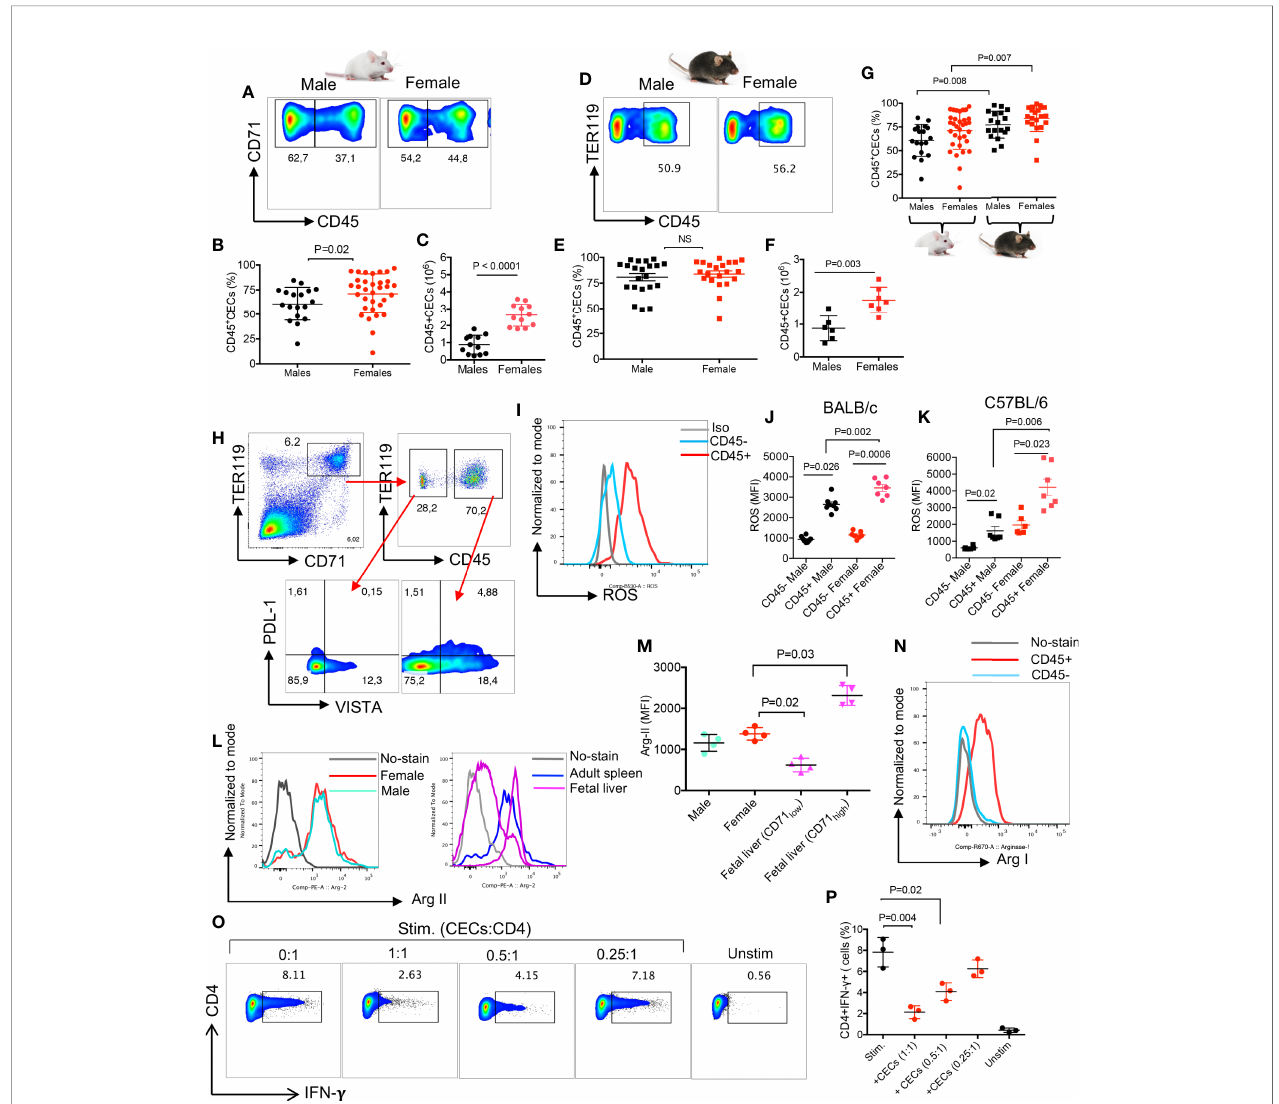
FIGURE 2 | CECs in adult mice express Arg II and ROS and suppress IFN- g production by T cell. (A) Representative fl ow cytometry plots, (B) cumulative data of percentages, and (C) absolute numbers of CD45+/CD45-CECs in the spleen of BALB/c male and female mice. (D) Representative fl ow cytometry plots, (E) cumulative data of percentages, and (F) absolute numbers of CD45+/CD45 − CECs in the spleen of C57BL/6 male and female mice. (G) Cumulative data comparing percentages of CD45+CECs in spleens of BALB/c and C57BL/6 male and female mice. (H) Representative fl ow cytometry plot of PDL-1 and VISTA expression in CD45 − and CD45+ CECs from a female BALB/c mouse. (I) Histogram plots, and (J) cumulative data of the mean fl uorescence intensity (MFI) for ROS expression in CD45 − and CD45+CECs in male and female BALB/c mice. (K) Cumulative data of MFI for ROS expression in CD45+ BALB/c male and female C57BL/6 mice. (L) Histogram plots, and (M) cumulative data of Arg II expression (MFI) in total CECs in male versus female mice compared to fetal liver CD71 low and CD71 high CECs. (N) Representative histogram plot of Arg I expression in splenic CD45+ and CD45 − CECs of a female BALB/c mouse. (O) Representative fl ow plots, and (P) cumulative data of IFN- g production by CD4+ T cells in the absence or presence of CECs at different ratios (CECs : CD4) after stimulation with anti-CD3/ CD28 antibodies for 6 h. Unstimulated (Unstim), stimulated with anti-CD3/CD28 (stim). Each point represents data from an individual mouse, representative of at least three independent experiments. Bar, mean ± standard